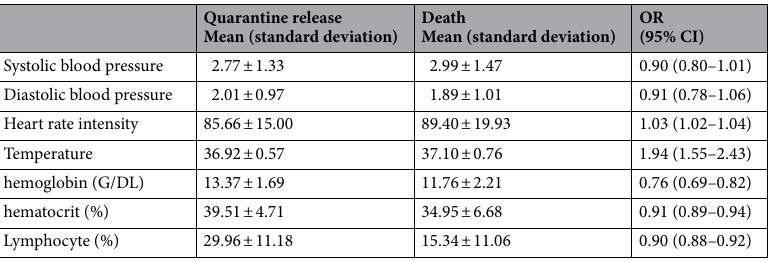
Table 2. Clinical and epidemiological characteristics of COVID-19 confirmed patients according to outcome status: continuous variable.